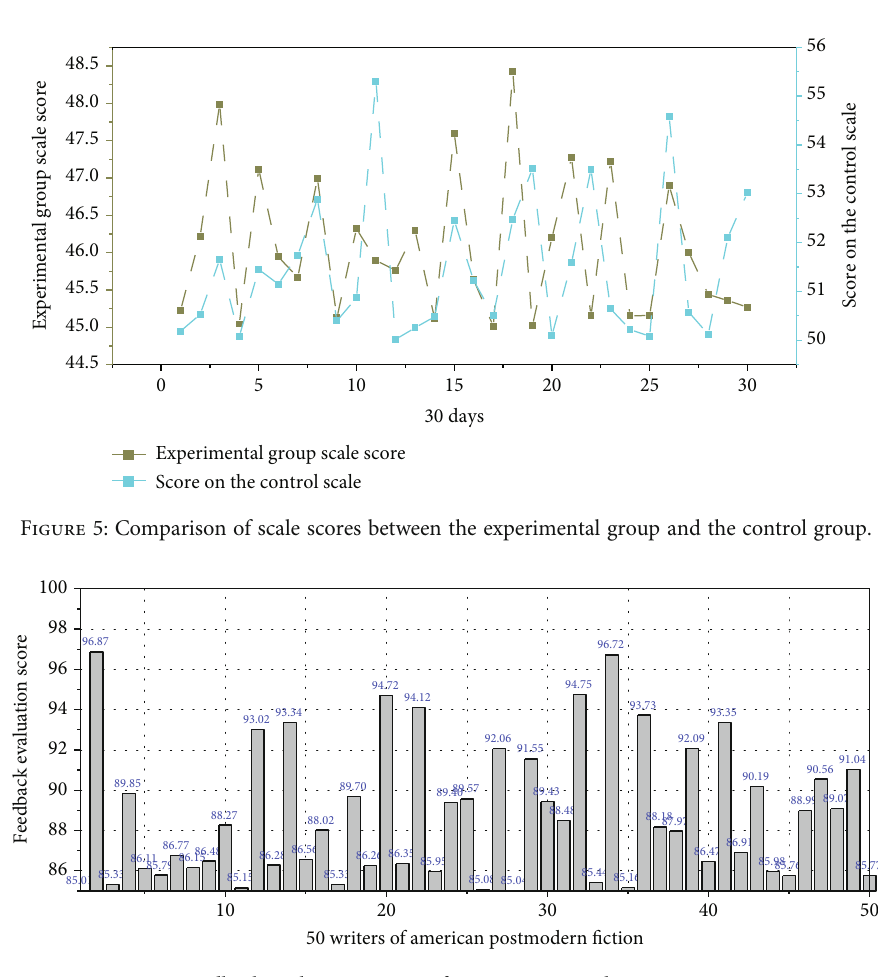
Figure 6: Feedback evaluation scores after treatment in the intervention